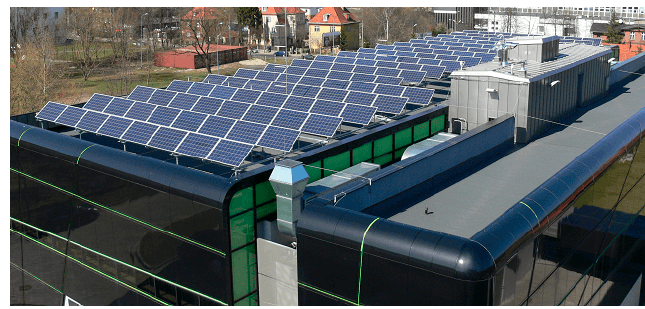
Figure 5. A view of photovoltaic panels installed on the roof of the LINTE^2 laboratory [41].